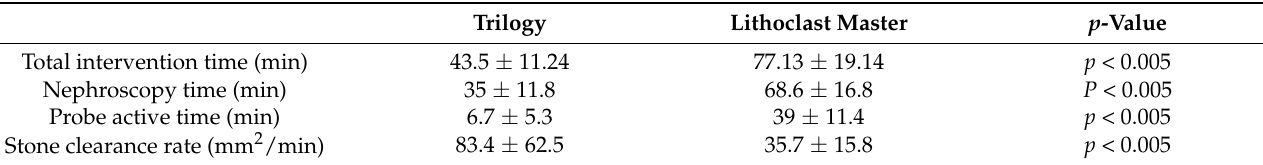
Figure 2. The control panel of the Trilogy device. Table 2. Intervention times and clearance rates in the Trilogy group. Table 3. Comparison of main surgical parameters between the two groups.